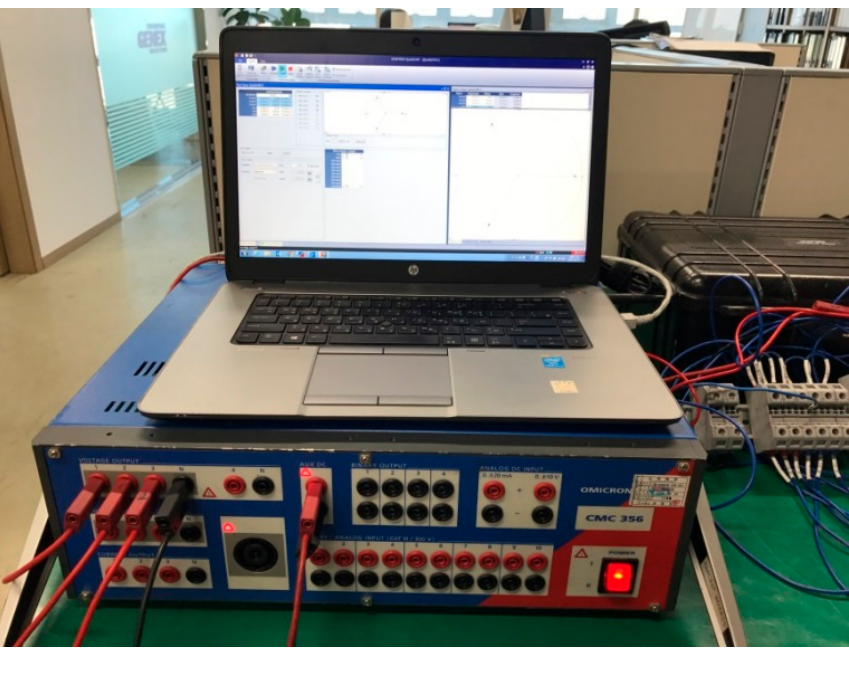
Figure 24. Testing equipment.